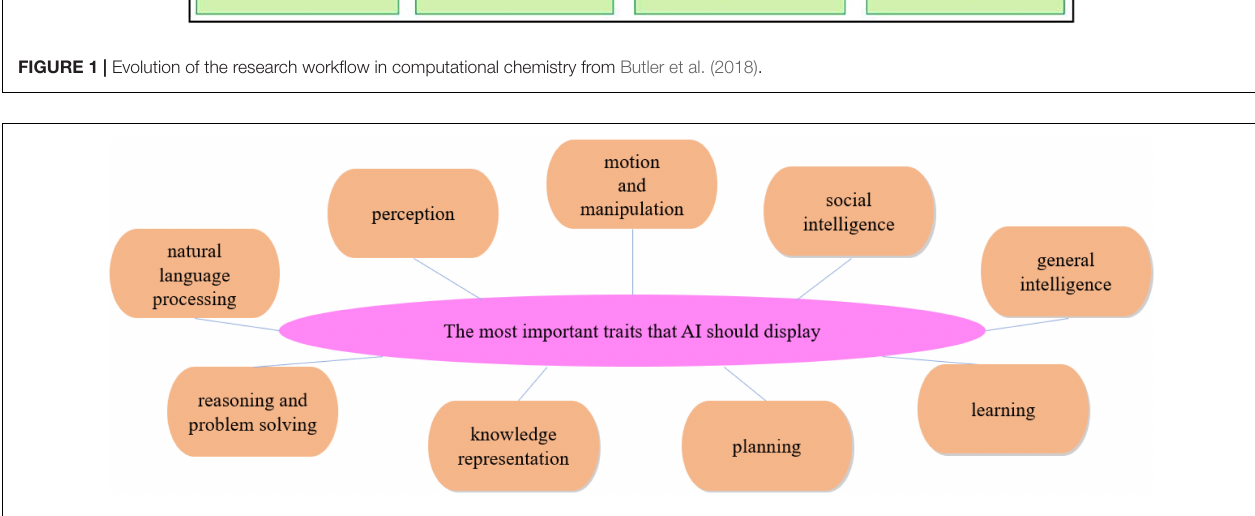
FIGURE 2 | Traits that an intelligent system need to